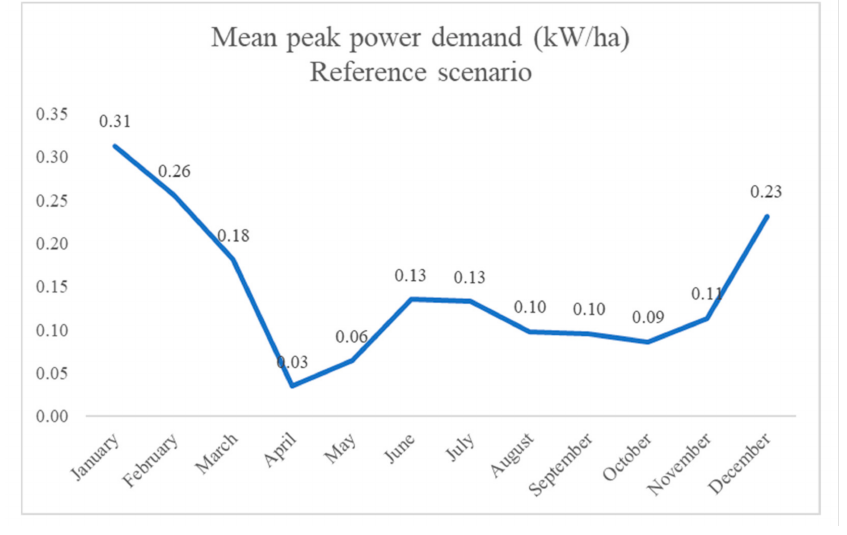
Figure 7. Mean peak power demand distribution (kW/ha) for irrigation water pumping throughout the year and study area in the reference scenario. The peak power demand remains rather stable between June and November and peaks in January. The lowest peak power demand is observed in